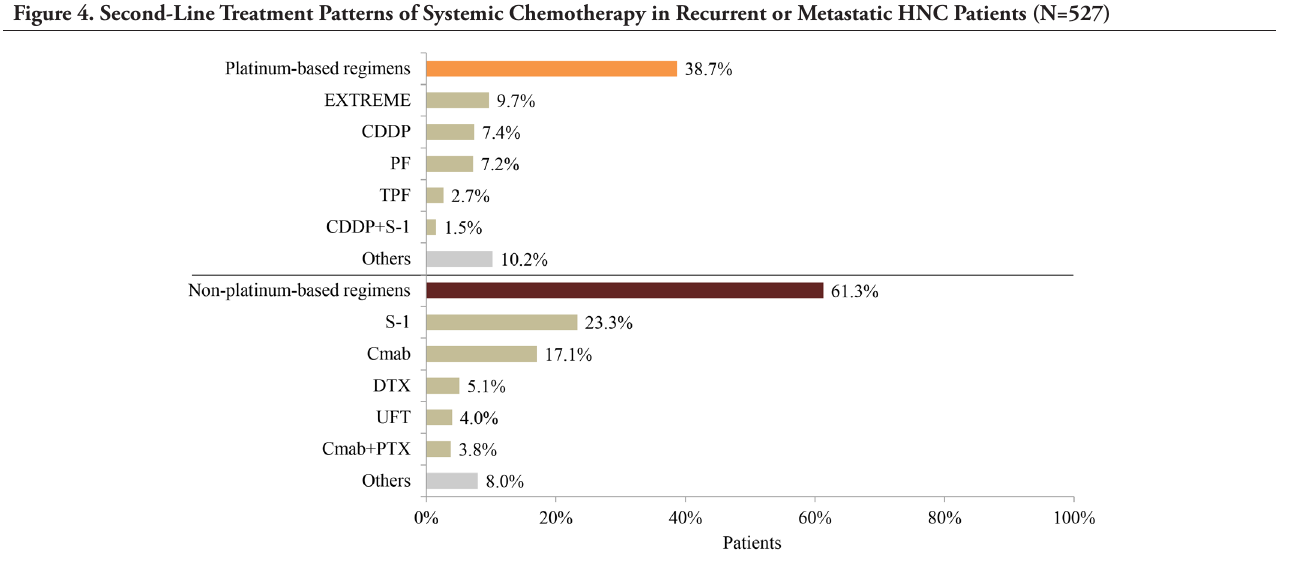
Figure 4. Second-Line Treatment Patterns of Systemic Chemotherapy in Recurrent or Metastatic HNC Patients